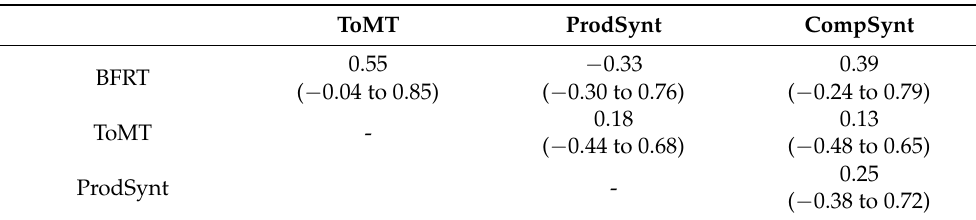
Table 3. Correlations for the WS group between Benton Facial Recognition Test (BFRT), Theory of Mind Test Revised (ToMT), ‘Production Syntaxique’ subtest (ProdSynt), and ‘Compr é hension Syntaxique’ subtest (CompSynt) and the 95% confidence intervals.